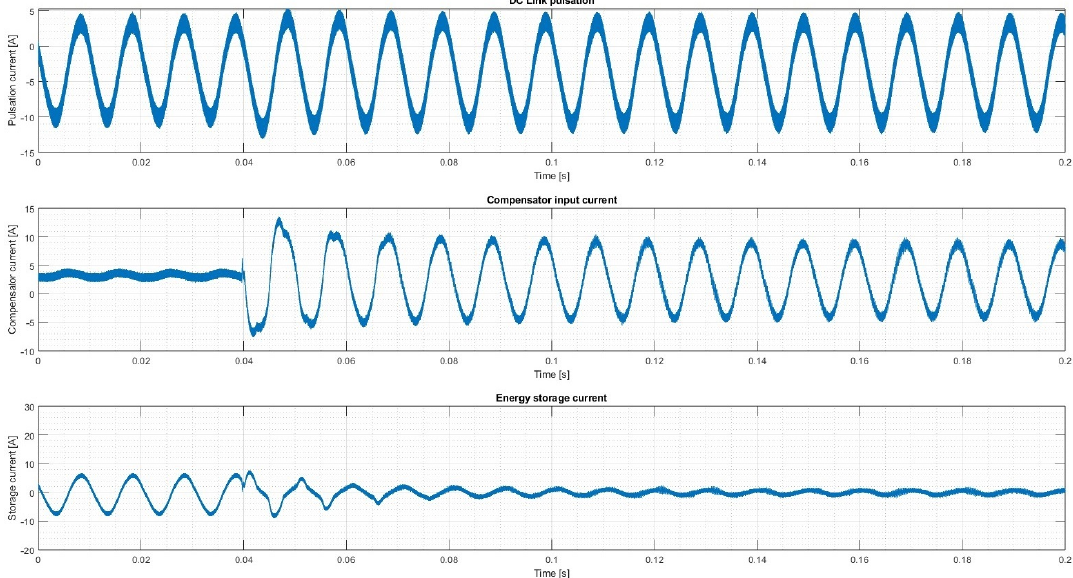
Figure 11. Cold start of the compensator.